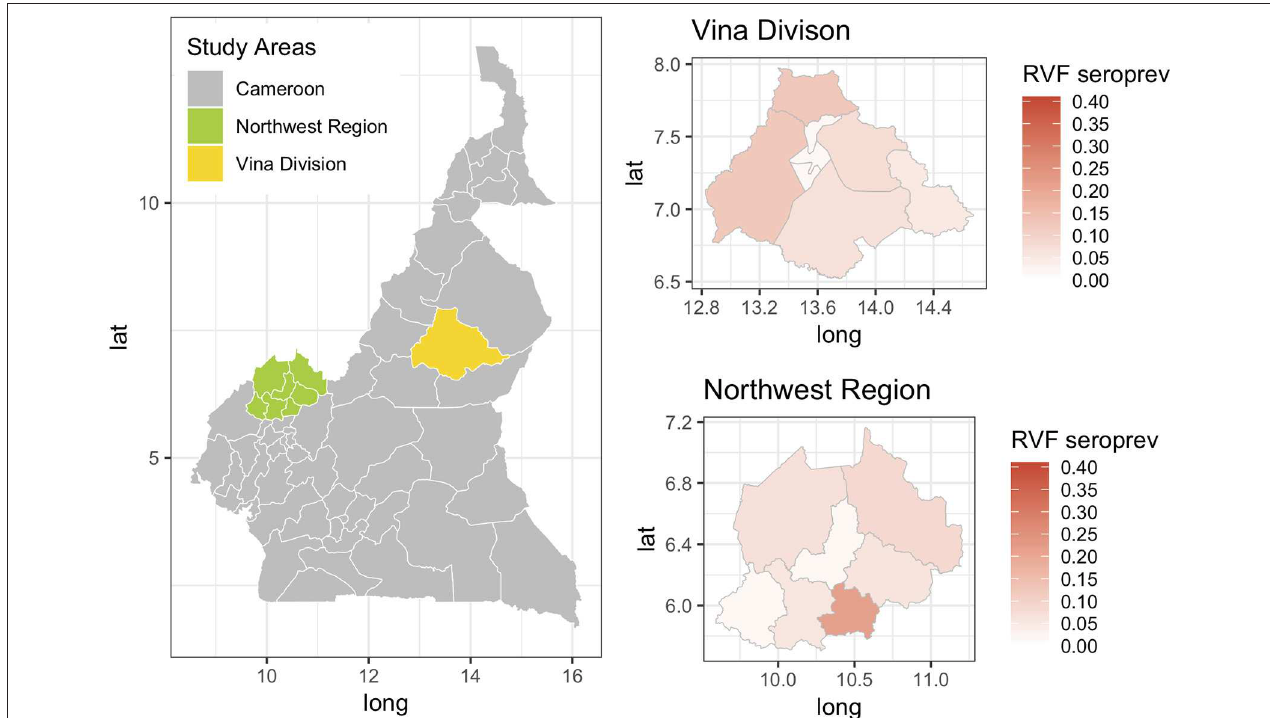
FIGURE 4 | Map showing the two study sites in the Northwest Region and the Vina Division of Cameroon. The smaller chloropeth maps show the mean estimated prevalence of rift valley fever seroprevalence for each site by Division (NWR) or sub-Division